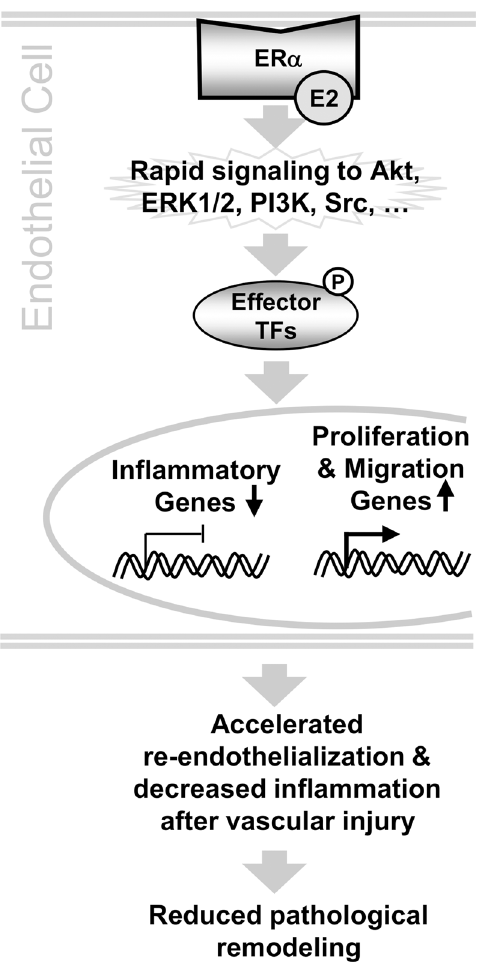
Fig 8. Model for gene regulation through E2/ER α rapid signaling. Rapid signaling from membrane bound E2/ER α , through striatin to Akt, ERK1/2, PI3K, Src and other cellular kinases, could phosphorylate and activate other TFs that regulate target genes that, then, promote EC proliferation and migration and reduce inflammatory responses in ECs. In vivo, these effects in ECs could promote re-endothelialization and inhibit long term pathological remodeling after vascular